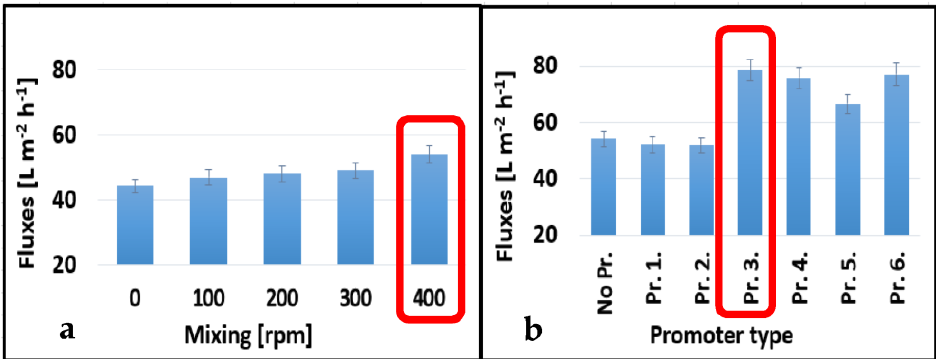
Figure 4. Effect of mixing speeds without 3DP turbulence promoters ( a ) and different promoters at 400 rpm mixing speed ( b ) on the average permeate fluxes of 150 kDa NMWL UF membrane. (T = 25 °C and TMP = 4 bar).